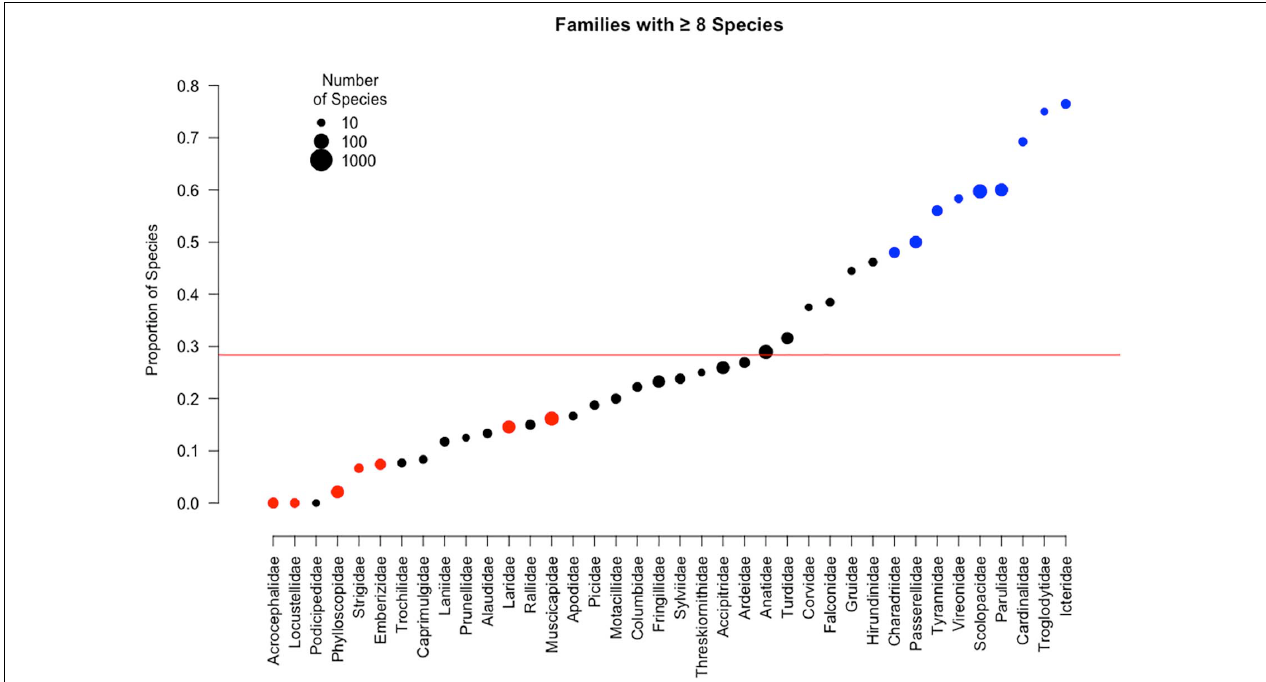
FIGURE 3 | The proportion of species by family that utilize temporary primary croplands. Point size indicates the total number of species within a category. Color represents the proportion of species within each group associated with cropland compared to the average association for migratory birds overall shown as a red line (28.3%): blue indicates a significantly higher than average proportion, red indicates a lower proportion than average, and black indicates non-significant results. No families with fewer than 8 migratory species had significantly higher or lower proportions of species that utilized agriculture for stopovers and were removed from the